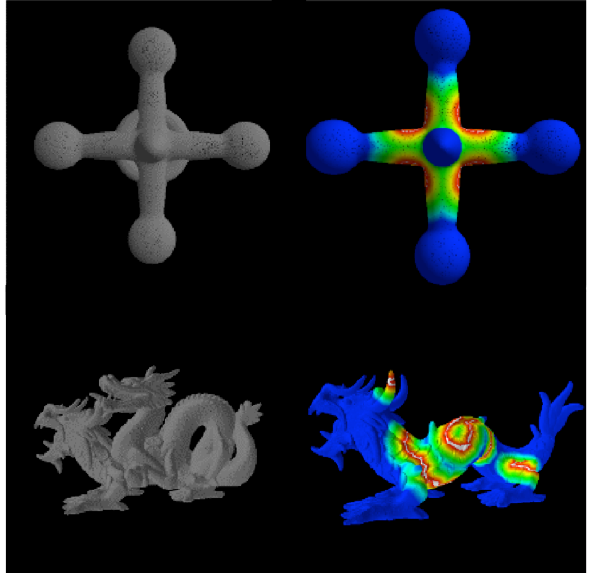
Figure 5. Examples of the colour assignment to visualize the collision risks between point-based surfaces. The top images show the collision of a hubby surface with a torus. The hubby surface is coloured. The bottom images show the collision between two types of dragon. The dragon with horns is